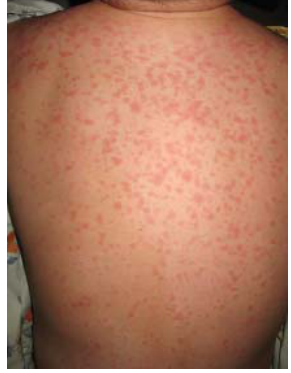
Figure 15. Viral